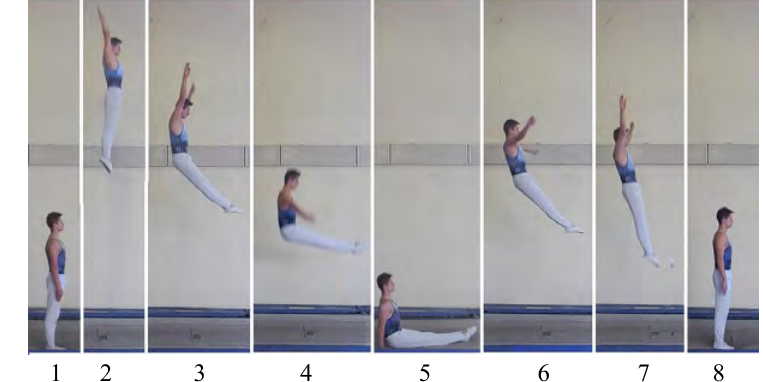
Fig. 5. Jump with landing in sitting position